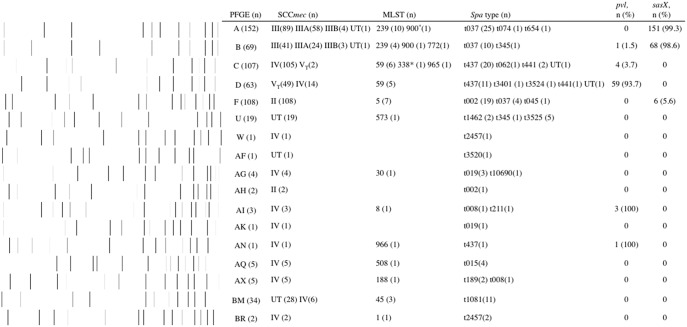
Molecular typing and carriage of virulence genes among 577 methicillin-resistant Staphylococcus aureus blood isolates in six major hospitals of Taiwan, 2010 stratified by pulsed-field gel electrophoresis (PFGE) types.*ST900 is a single locus variant (SLV) of ST239; ST338 is a SLV of ST59. Abbreviations: UT, untypeable; PFGE, pulsed-field gel electrophoresis; MLST, multilocus sequence type; pvl, Panton-Valentine leukocidin genes; sasX, SasX gene.